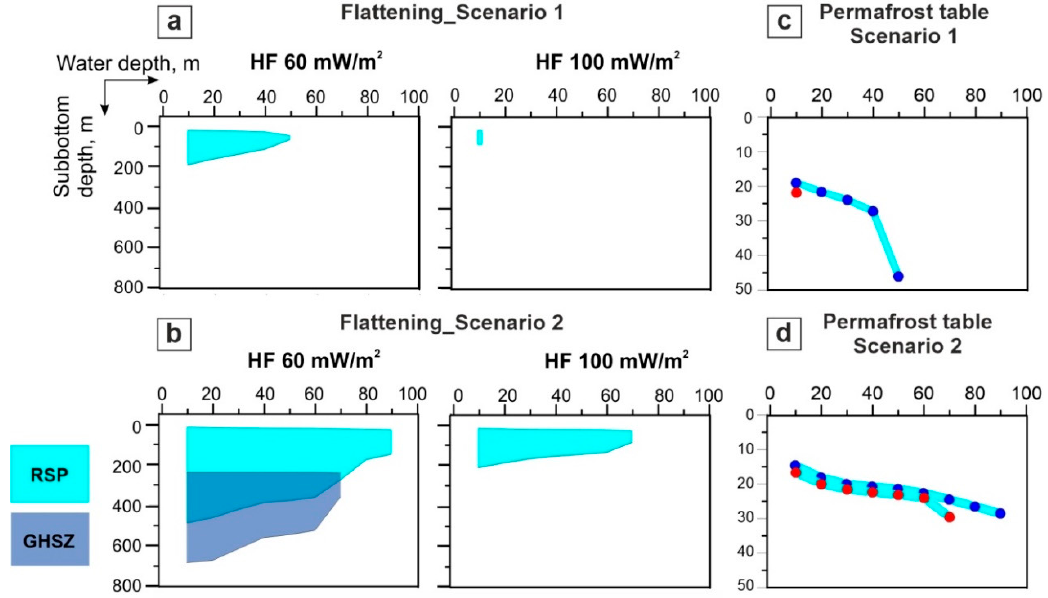
Figure 5. ( a , b ) Comparison of RSP and GHSZ geometries at different HFs. ( c , d ) Position of permafrost table calculated for both simulated scenarios with HF = 60 mW/m 2 (the navy blue line with blue dots); HF = 100 mW/m 2 (the navy blue line with red dots); gas hydrate content = 0%.